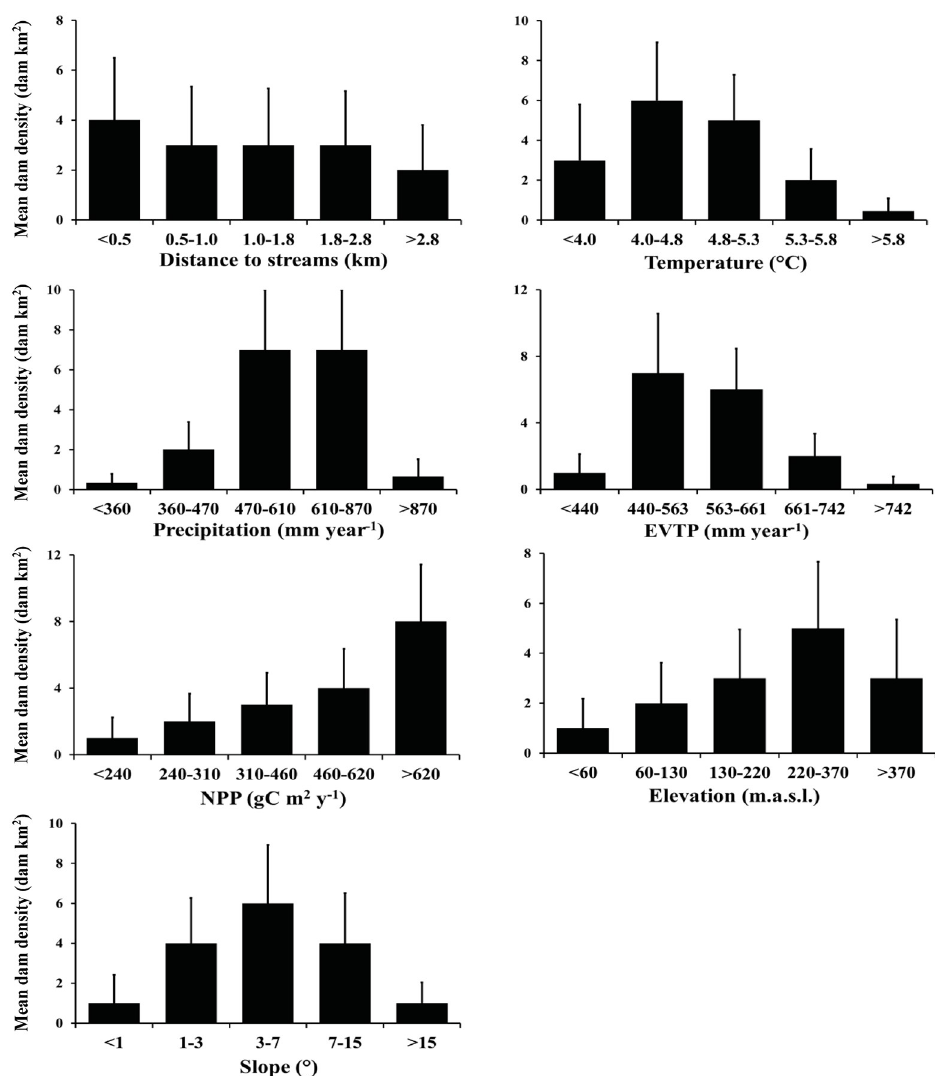
Fig 5. Mean beaver dam densities (dam per km 2 ) at different levels of each analyzed geographic, climatic and topographic factor. Error bars represent the standard deviation. NPP = net primary productivity, EVTP =